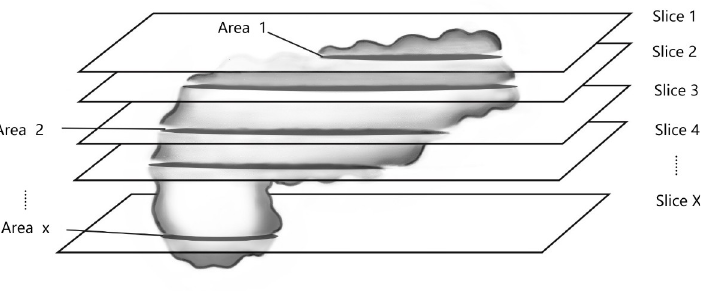
Fig 4. Interval selection measurement of pancreatic layer to calculate half-pancreatic fat content (hPFF).